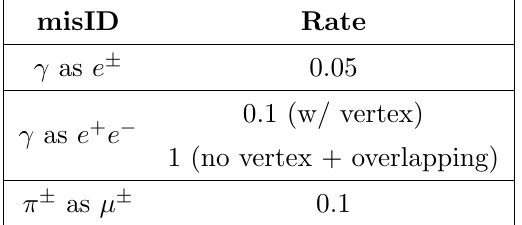
Table 4 . Assumed misID rates for various particles in a LAr detector. We take these values to be constant in